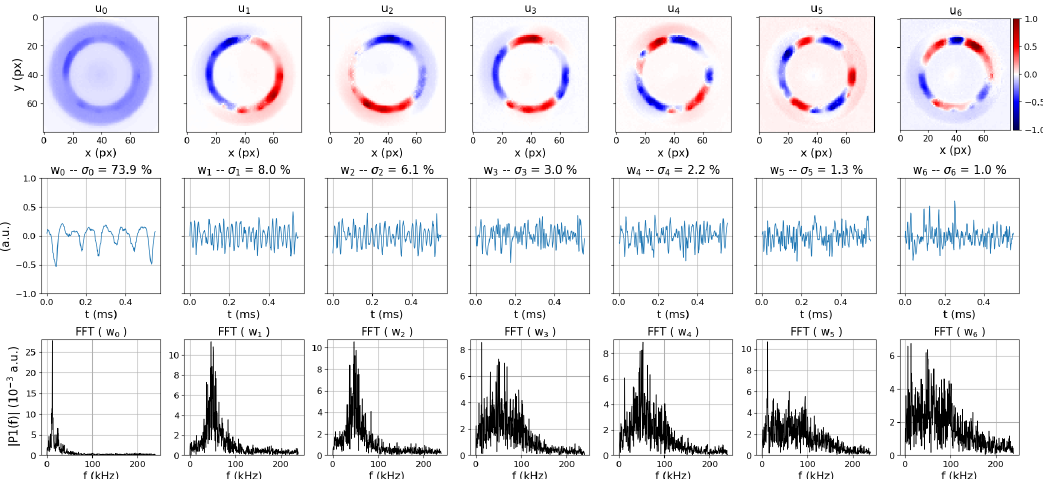
Figure 4. Nominal regime : POD analysis of the front videos with a discharge voltage U d = 250 V, a mass flow rate Q = 1.8 mg · s − 1 , a cathode heating current I H = 19.95 A ( I H / I H , crit = 1.08) and a acquisition frequency of F fps = 480 kfps. (Top) Spatial POD modes u i ; (Middle) corresponding temporal POD modes w i with their singular value λ i given as σ i = λ 2 over the sum of all the λ i expressed as a i percentage; and (Bottom) corresponding